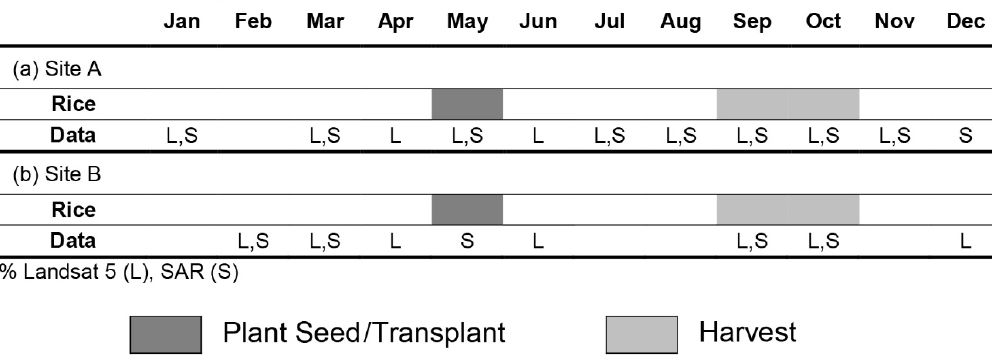
Figure 2. Rice planting and harvest schedules, and satellite data availability.